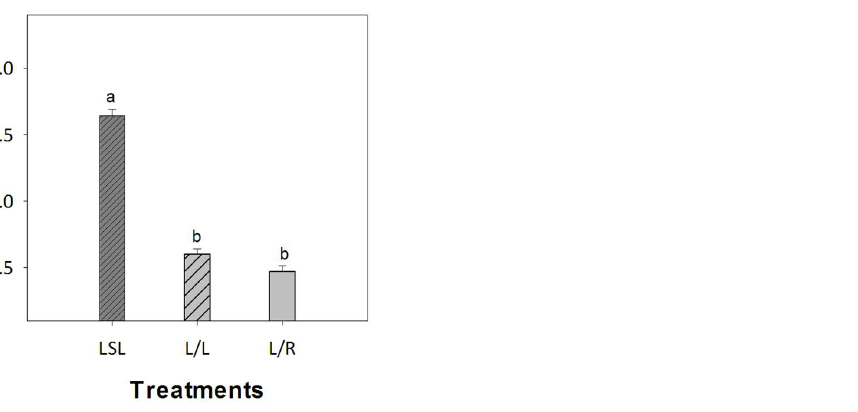
Figure 8. Pulp firmness (Newton) of the fruit produced by treatments LSL (long-shelf-life tomato), L/L (self-grafted Old Limachino tomato) and L/R (grafted Old Limachino tomato on Poncho Negro rootstock) under greenhouse conditions. Each value represents the mean ± SE ( n = 12). Lower-case letters indicate differences ( p ≤ 0.05, Duncan test) among treatments.